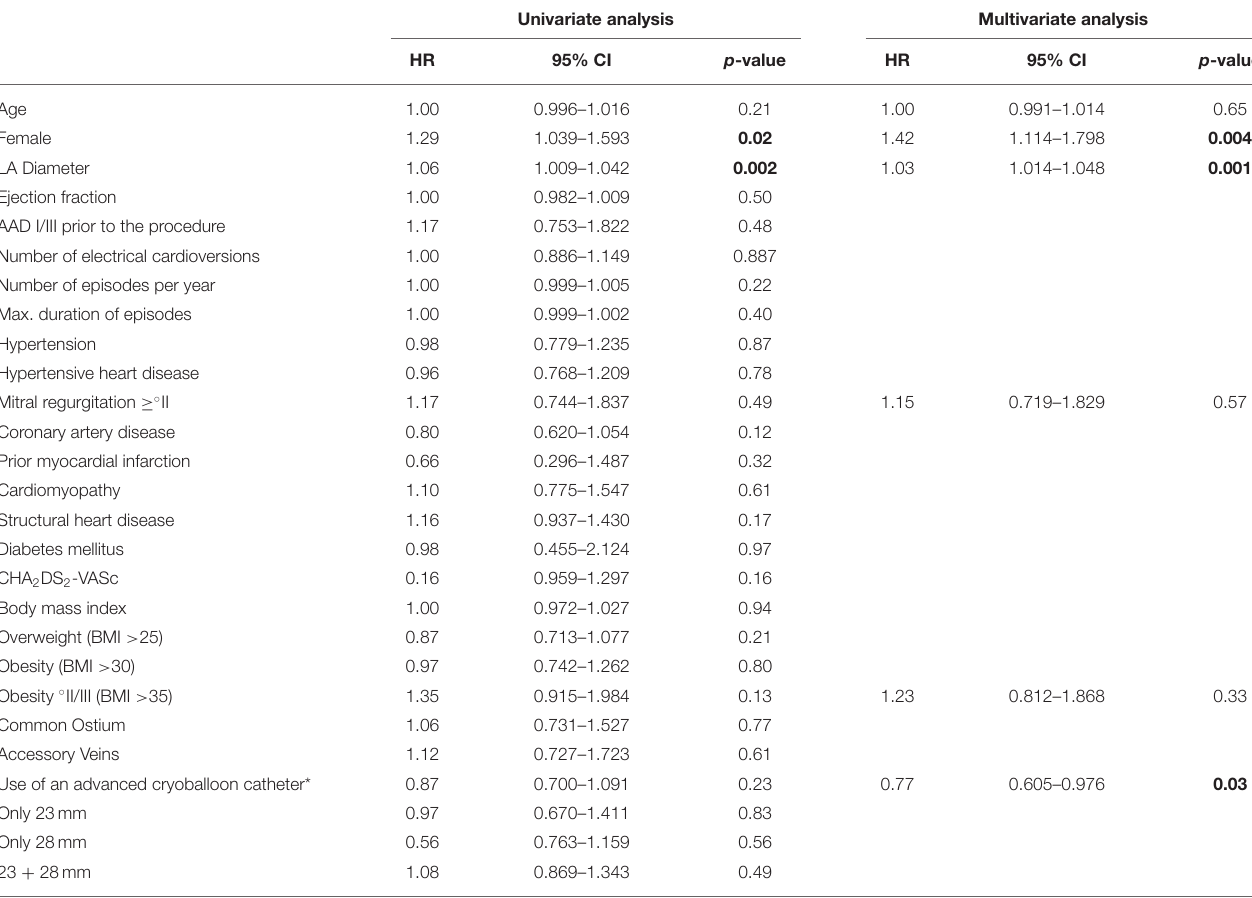
TABLE 4 | Predictors of outcome: uni- and multivariate analyses. Univariate analysis Multivariate